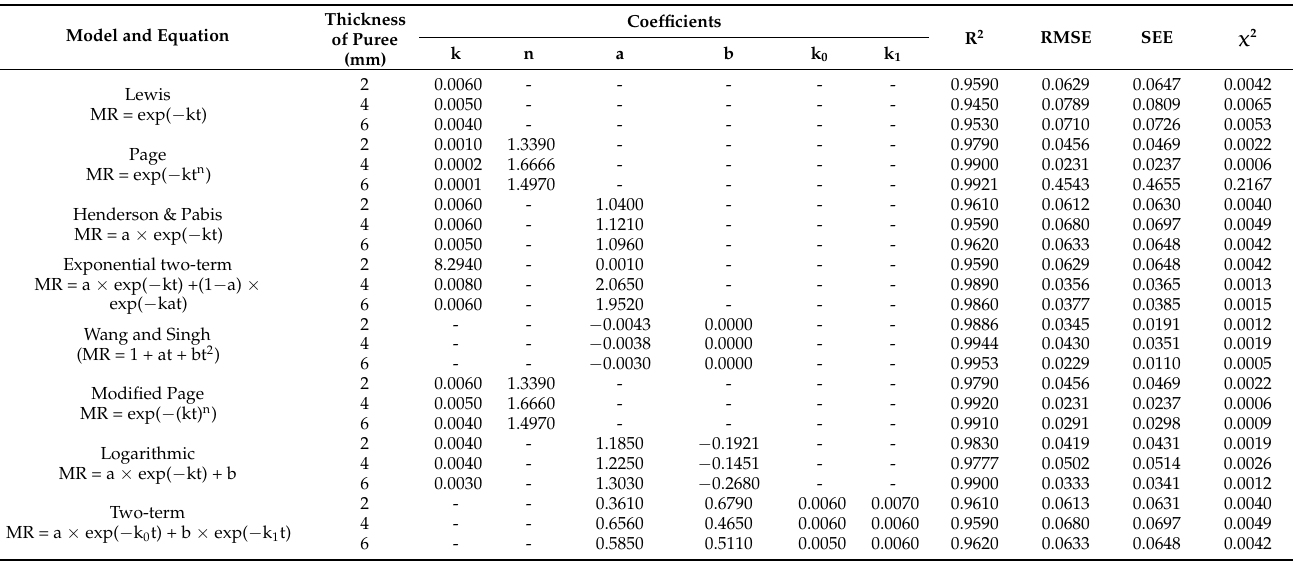
Table 2. Mathematical models used to predict the moisture ratio values and regression coefficients with statistical parameters of convective-dried samples.